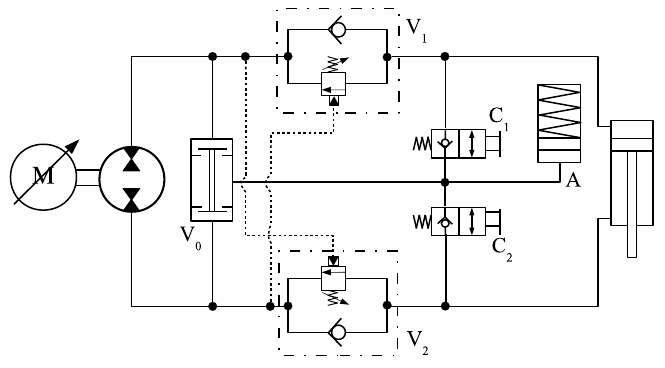
Figure 25. Circuit with a logic valve.